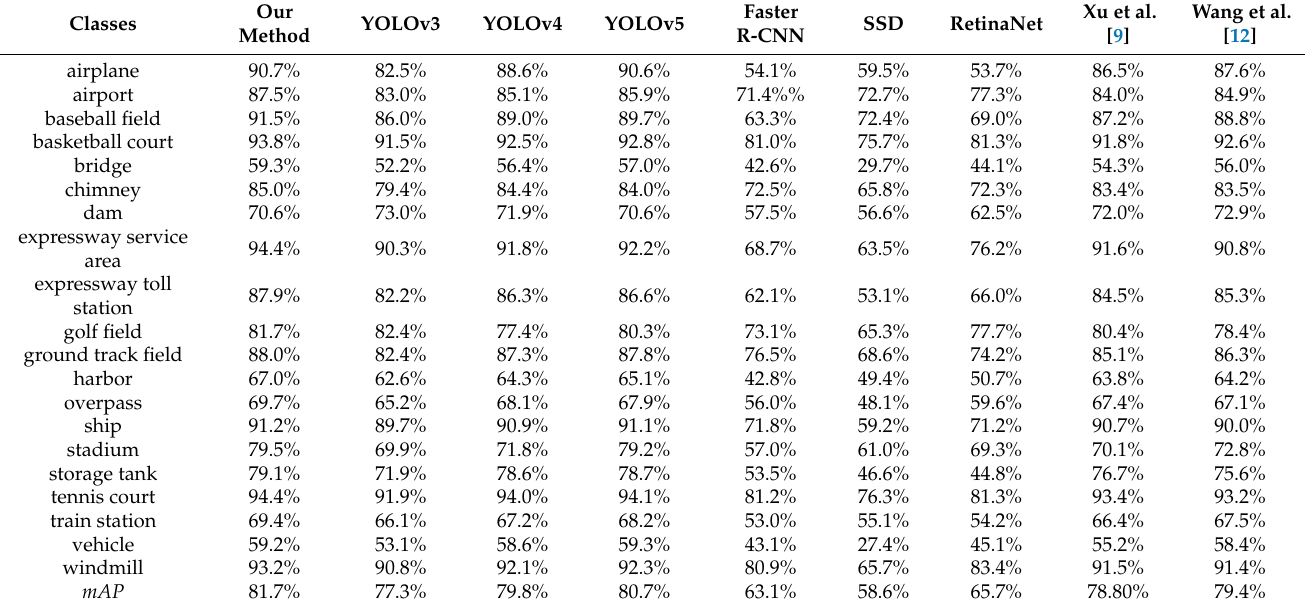
Table 4. The experimental results on the DIOR